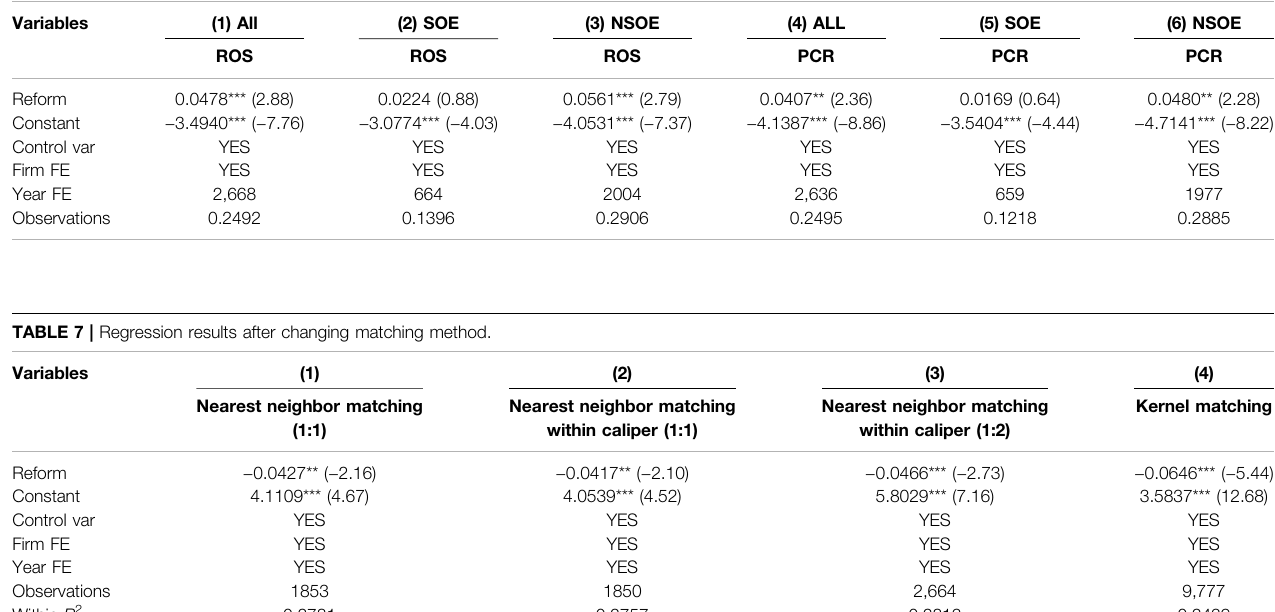
TABLE 6 | Results of enterprise performance test. Variables